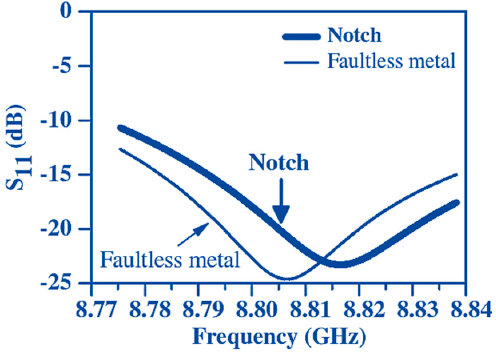
Figure 4. Schematic drawing of the electric dipole probe above a notch. W , h and L represent the width, depth and length of the notch, respectively. d is the probe ‐ to ‐ metal distance (from [29]; copyright © 2008; redesigned with permission).